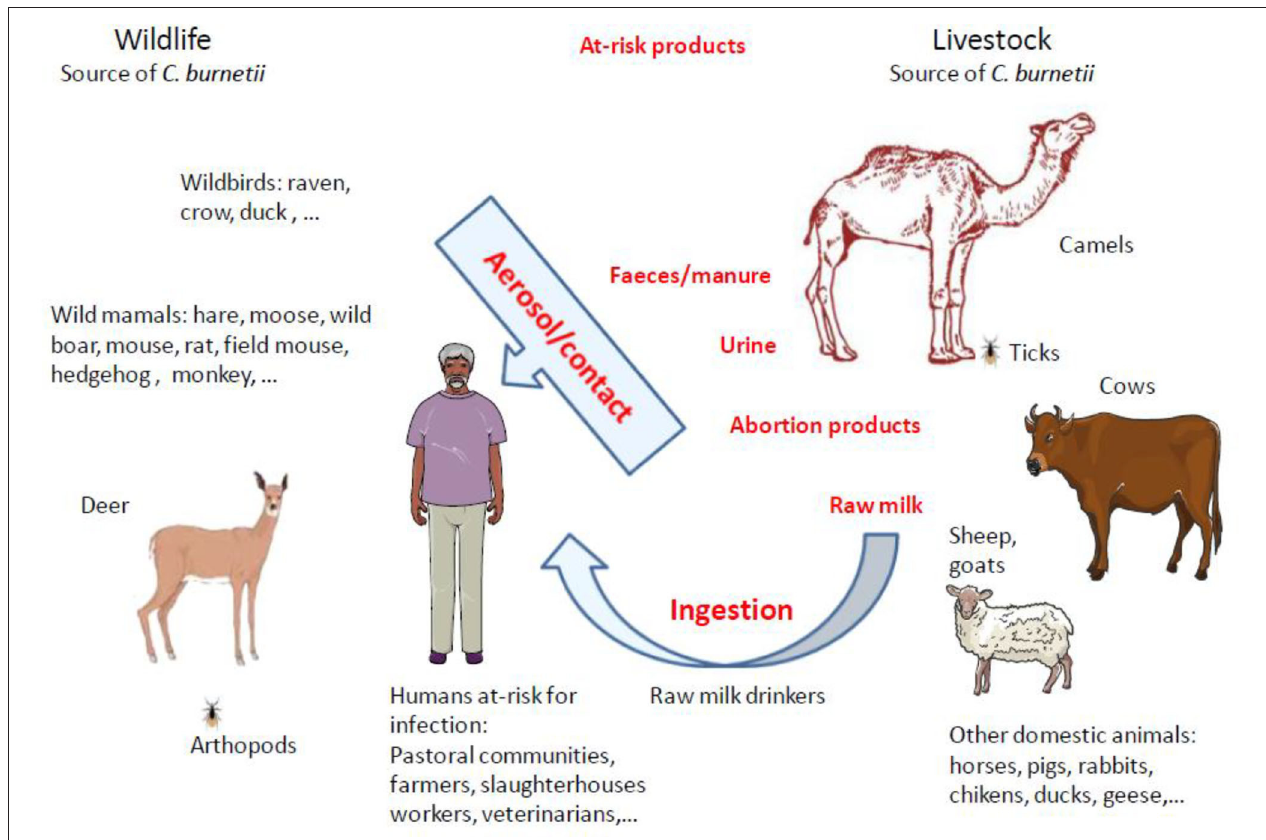
FIGURE 4 | Schematic representation of animal reservoirs diversity and main routes of animal-to-human transmission of Q fever. Up to now, domestic ruminants were considered the principal reservoirs for C. burnetii and were frequently incriminated as sources of Q fever outbreaks in humans. However, in North Africa and Middle East were camels live, it was reported that most of the time the seroprevalence of anti– C. burnetii Ig was much higher in dromedary camels than in other ruminants. C. burnetii shedding is higher in vaginal mucus and feces than in milk. The infection in humans by Coxiella burnetii is mainly by inhalation of aerosols. It was evidenced that C. burnetii can be transmitted during arthropod blood-sucking. Among ticks, the Hyalomma dromedarii that colonize dromedari camels was found infected with C. burnetii . Human populations at risk of C. burnetii infection are pastoral communities, farmers, slaughterhouses workers, tanneries workers, veterinarians, or individuals handling infected livestock, especially animals giving birth. Raw milk drinkers are also at risk. With the increasing demand of milk and camel meat in urban areas, there is a potential threat for millions of